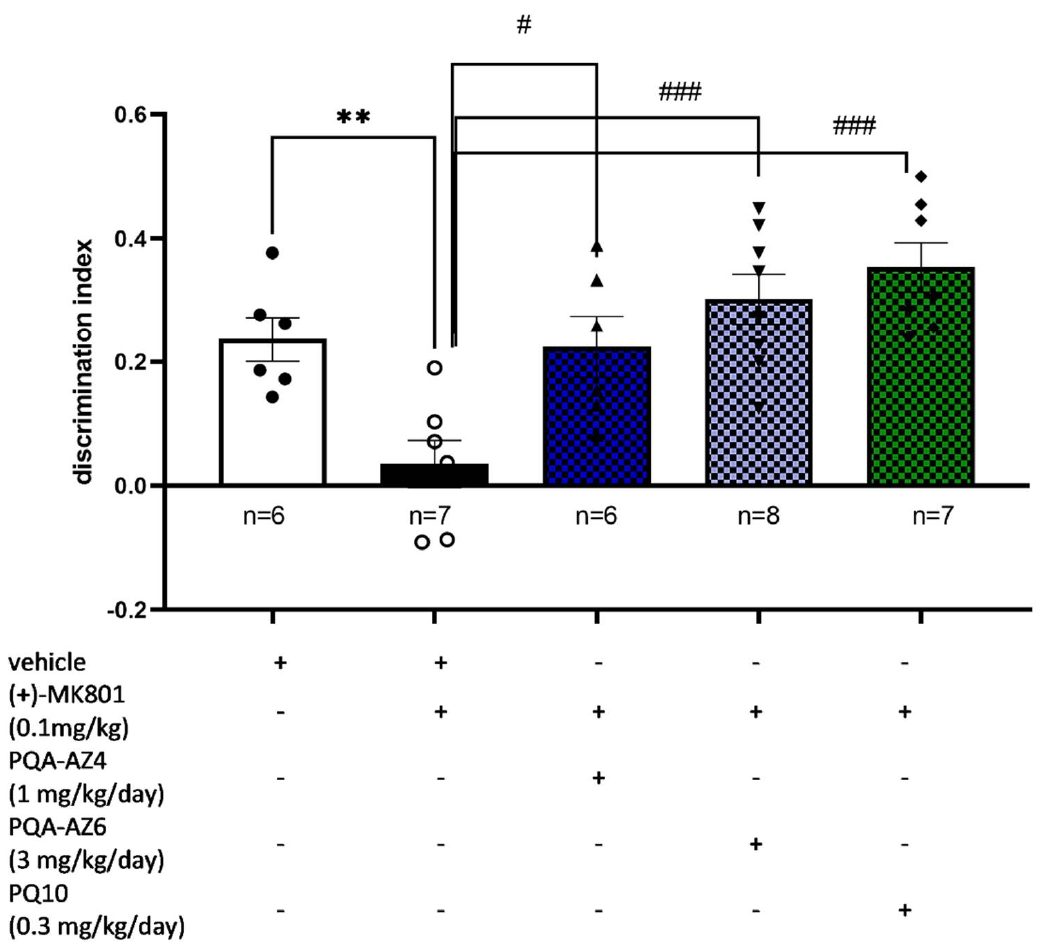
Figure 3. Effects of repeated administration of PQA-AZ4, PQA-AZ6, and PQ-10 on (+)-MK-801-in- duced memory deficits in the NOR test conducted on rats. PQA-AZ4, PQA-AZ6, and PQ-10 were administered i.p. once daily for 21 consecutive days. (+)-MK-801 was injected i.p. 30 min before the first trial (familiarization, T1) phase. Data represent the mean ± SEM, n = 6–8 rats per group; one- way ANOVA followed by Bonferroni’s post hoc test, ** p < 0.01 vs. respective vehicle-treated group # p < 0.05, ### p < 0.001 vs. respective (+)-MK-801 treated group.